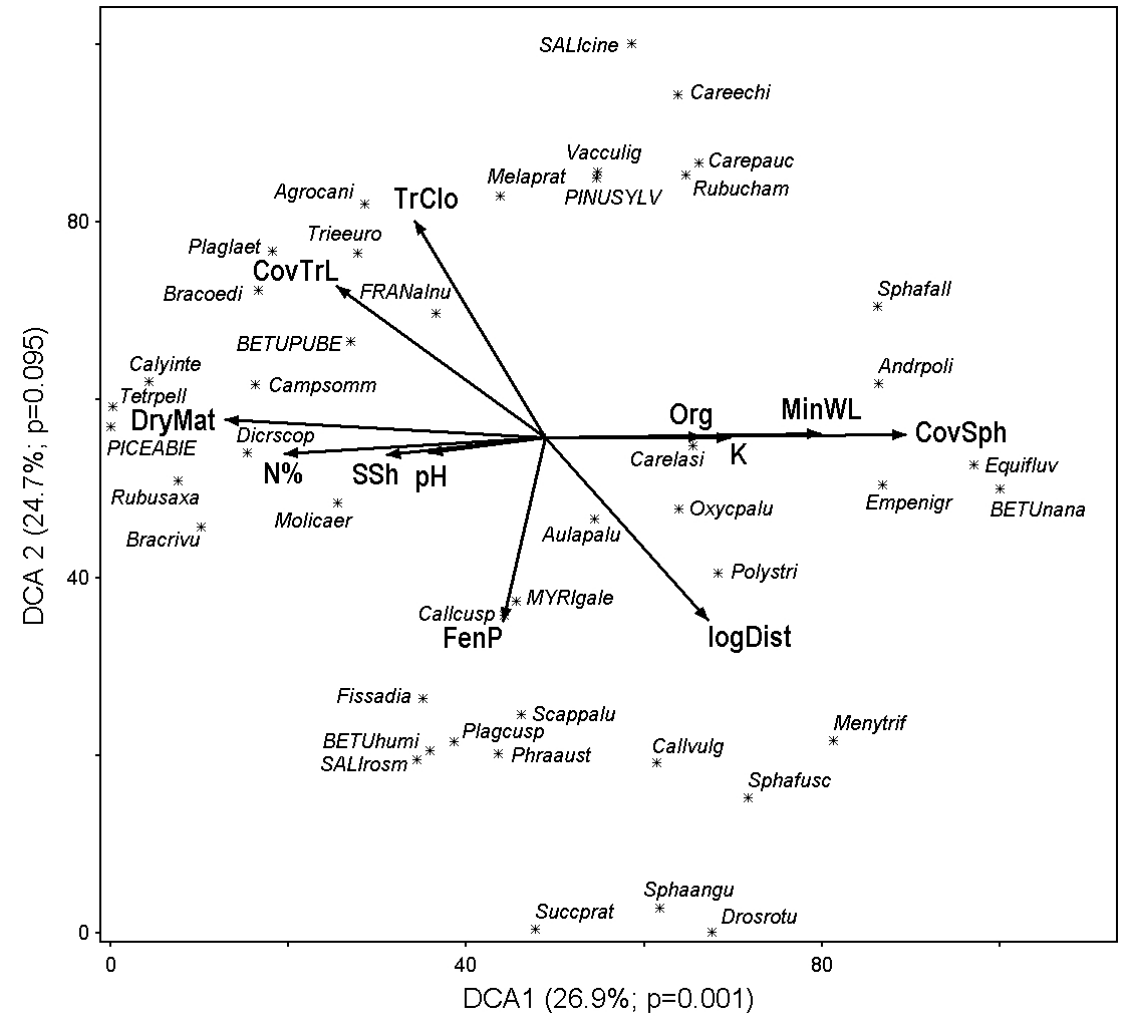
Figure 15. DCA biplot of the most indicative species and main variables determining the vegetation structure and environmental conditions. Abbreviations: DryMat = content of dry matter in peat; CovTrL = tree layer cover derived from LIDAR data; TrClo = tree layer canopy closure; Org = content of C (organic matter) in soil; K = total-K content of soil; MinWL = minimum water level; CovSph = total cover of Sphagnum species; logDist = log-transformed distance from cutoff ditch; FenPe = thickness of fen peat; pH = pH of peat water; SSh = number of shrub layer species; N% = total-N content of soil. Tree species: BETUPUBE = Betula pubescens, PICEABIE = Picea abies, PINUSYLV = Pinus sylvestris ; shrubs: BETUhumi = Betula humilis, BETUnana = Betula nana, FRANalnu = Frangula alnus, MYRIgale = Myrica gale, SALIcine = Salix cinerea, SALIrosm = S. rosmarinifolia ; field layer species: Agrocani = Agrostis canina, Andrpoli = Andromeda polifolia, Callvulg = Calluna vulgaris, Careechi = Carex echinata, Carelasi = C. lasiocarpa, Carepauc = C. pauciflora, Drosrotu = Drosera rotundifolia, Empenigr = Empetrum nigrum, Equifluv = Equisetum fluviatile, Melaprat = Melampyrum pratense, Menytrif = Menyanthes trifoliata, Molicaer = Molinea caerulea, Oxycpalu = Oxycoccus palustris, Phraaust = Phragmites australis, Rubucham = Rubus chamaemorus, Rubusaxa = R. saxatilis, Succprat = Succisa pratensis, Trieeuro = Trientalis europaea, Vacculig = Vaccinium uliginosum ; moss layer species: Aulapalu = Aulacomnium palustre, Bracoedi = Brachythecium oedipodium, Bryum_sp = Bryum sp ., Callcusp = Calliergonella cuspidata, Calyinte = Calypogeia integristipula, Campsomm = Campylium sommerfeltii, Dicrscop =Dicranum scoparium, Fissadia = Fissidens adianthoides, Plagcusp = Plagiomnium cuspidatum, Plaglaet = Plagiothecium laetum, Polystri = Polytrichum strictum, Scappalu = Scapania paludicola, Sphaangu = Sphagnum angustifolium, Sphafall = S. fallax, Sphafusc = S. fuscum, Tetrpell = Tetraphis